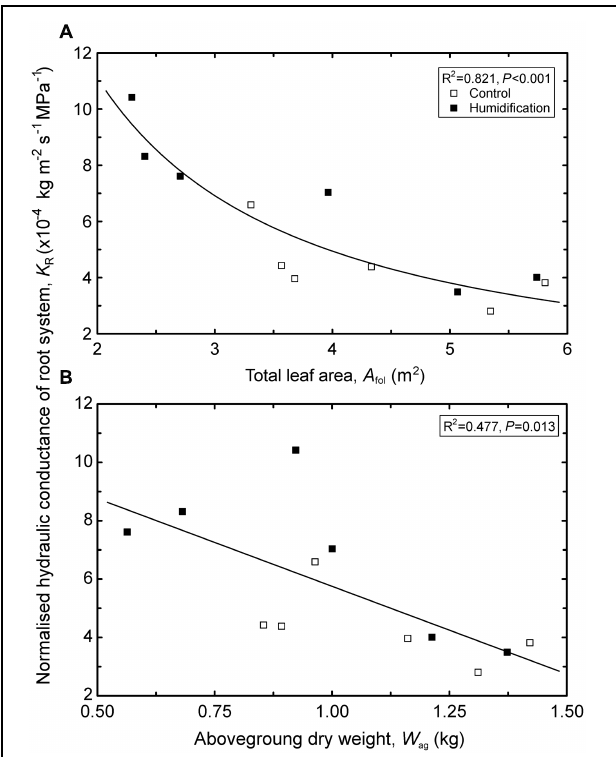
FIGURE 3 | Leaf hydraulic conductance ( K L ) calculated as a tree’s mean weighted by foliar area of the sample branches versus live crown length (LCL; A) and tree height ( h ; B). Regression equations: A – y = 2 . 38 · e 1 . 04 · 10 − 4 x 6 . 66 ; B – y = 2 . 15 · e 3 . 87 · 10 − 4 x 5 . 35 .